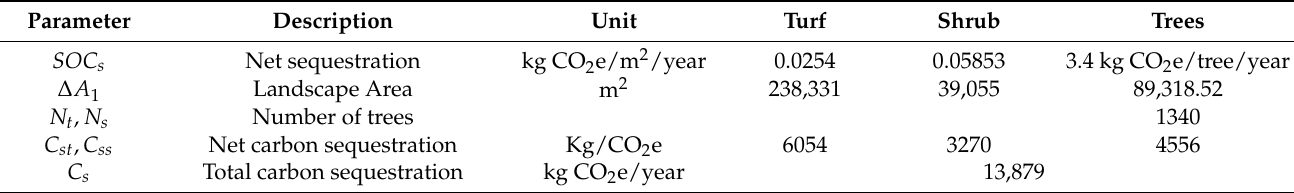
Table 2. Fuzzy classes and their corresponding percentiles.